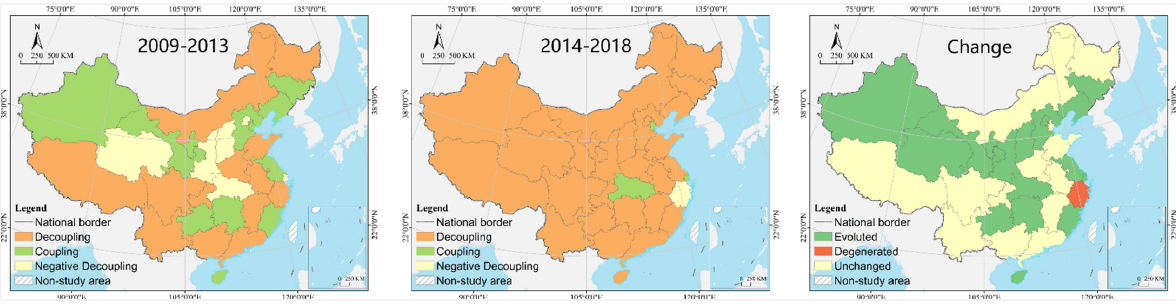
Figure 7. Analysis on the three types of decoupling relationships in gross output value.